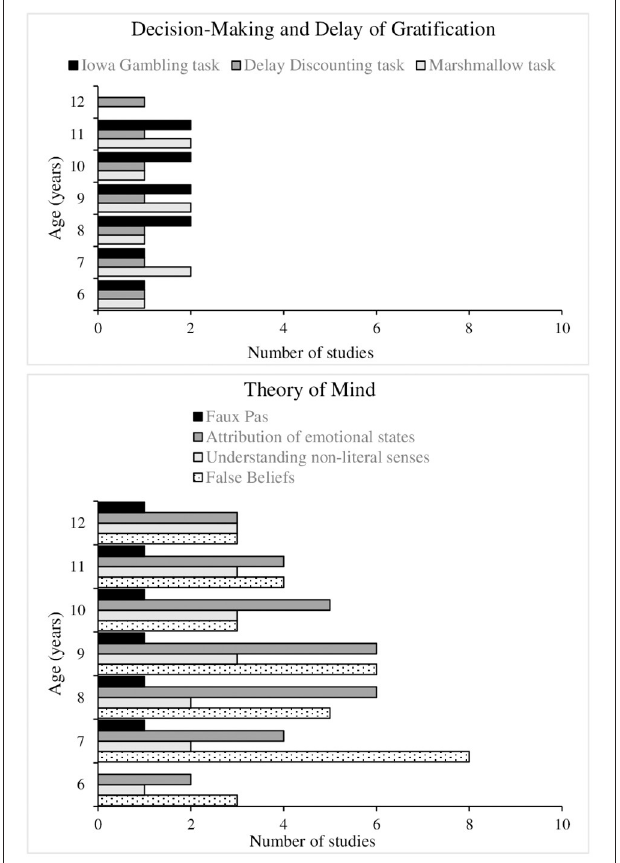
FIGURE 5 | Frequency of task type used to evaluate hot EFs in reviewed studies, by age